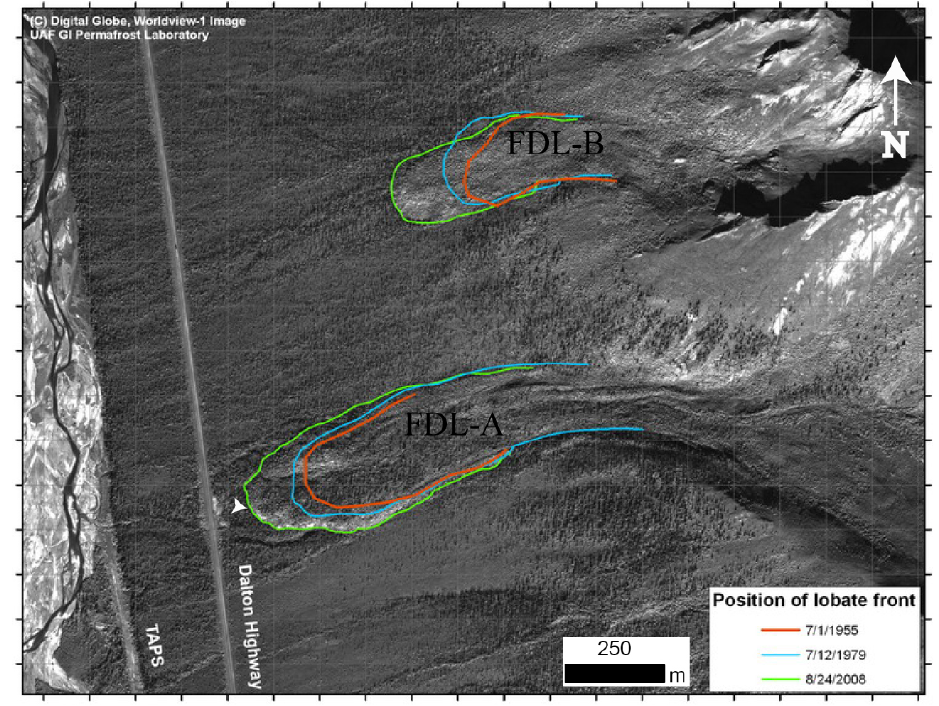
Fig. 7. Comparison of the termini positions of FDL-A and FDL-B between 1955 and 2008 from high-resolution aerial and satellite based remotely sensed imagery. Two drainage channels in front of the lobe drain FDL-A and are not part of the moving body. The white arrow near the terminus of FDL-A indicates the repeat photo camera location illustrated in Fig. 10.